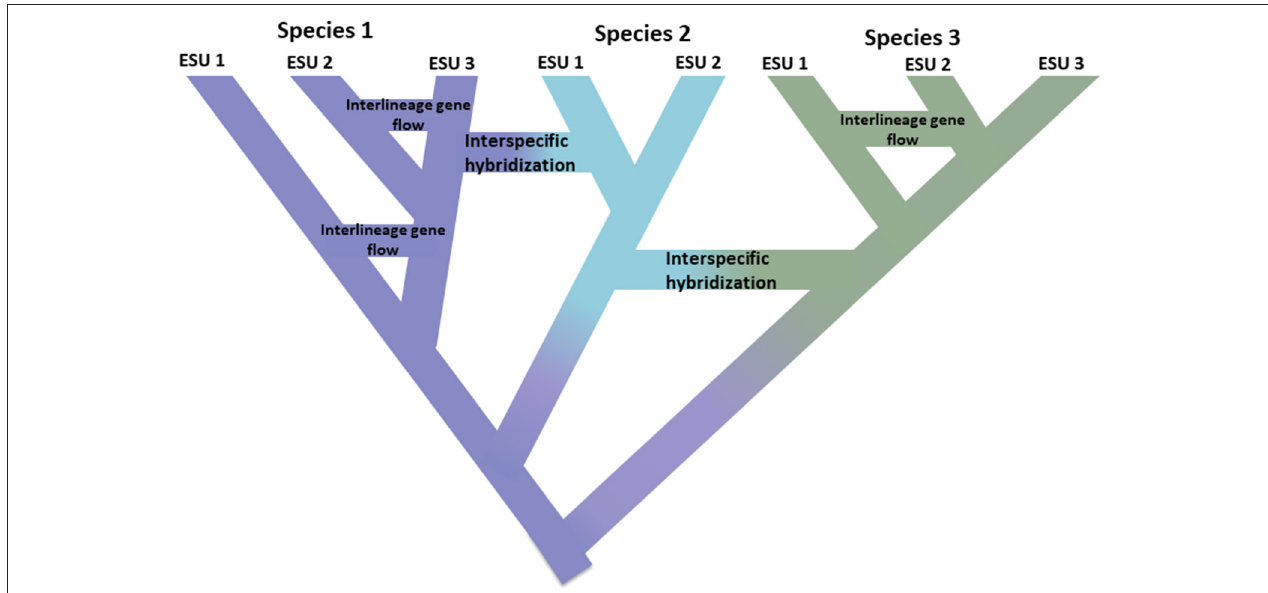
FIGURE 1 | Speciation as a continuum progressing from isolated populations to unambiguous species shown by the shift in color with the colors representing different species. Some lineages that arise due to population isolation develop into true species with the internal nodes of the tree representing initiation of the speciation process. Other lineages do not develop into true species but diverge over time indicating that species are not genetically uniform. These lineages are shown as Evolutionarily Significant Units (ESUs). Inter-lineage gene flow is indicated for Species 1 and Species 3. In this case, evolutionary independence may be transient because two lineages belonging to the same species are not reproductively isolated. While they remain as distinct lineages (species), interspecific hybridization may occur with limited gene exchange (shift in color) between